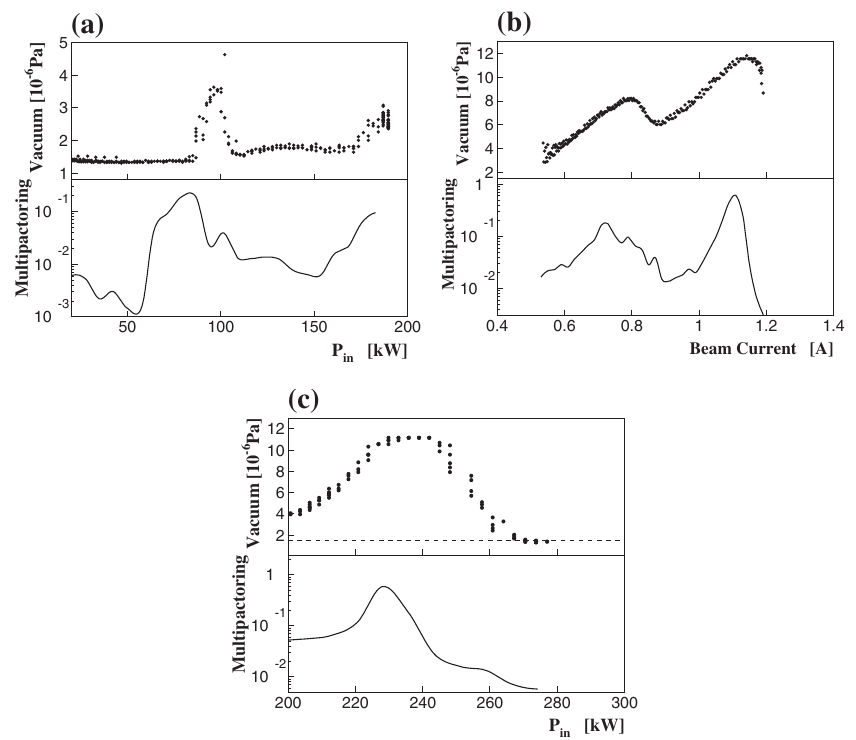
FIG. 5. Vacuum data of CavityM (upper) and calculation results of M (lower) as a function of the input rf power or the HER beam current. The dashed line in (c) indicates a typical vacuum pressure in the other cavities with no multipactoring problem. The trajectories of the operating point for (a), (b), and (c) are shown in Figs. 4(b)–4(d),